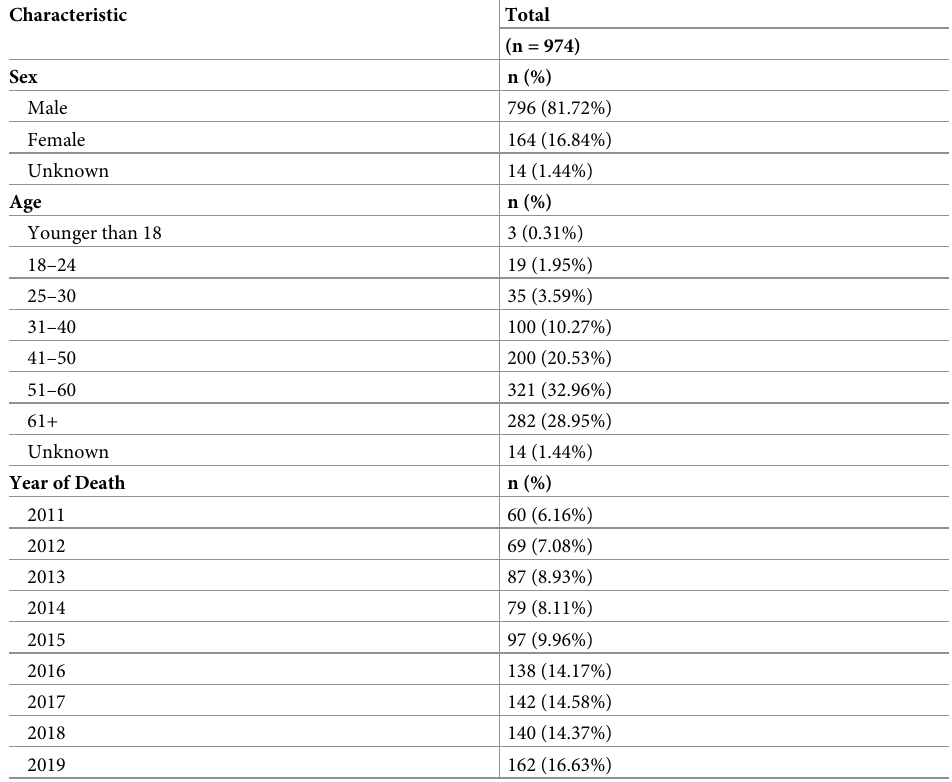
Table 2. Characteristics of unhoused individuals who died in Santa Clara County between 2011 and 2019 (n = 974). Characteristic Total